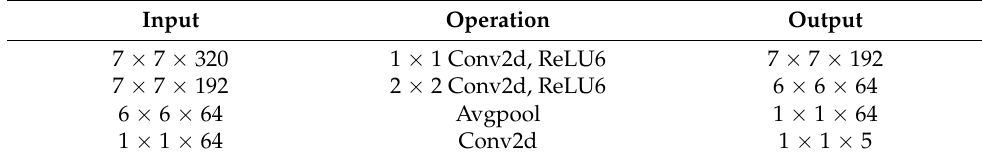
Table 2. Improved classifier